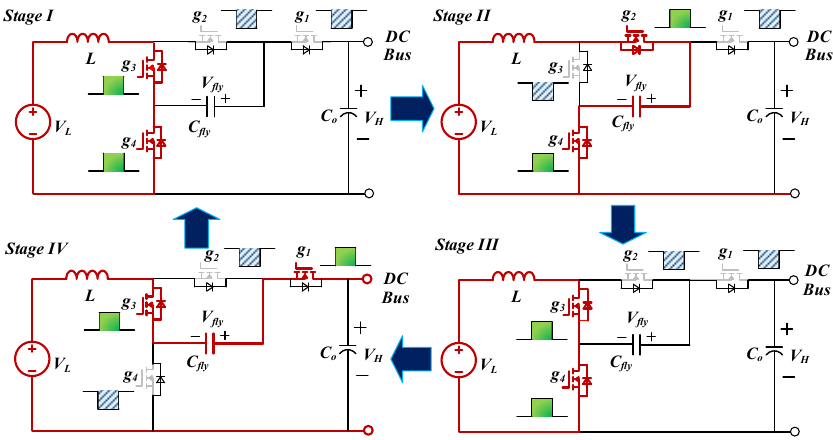
Figure 5. Stages of the three-level mode when V L < 0.5 V H.